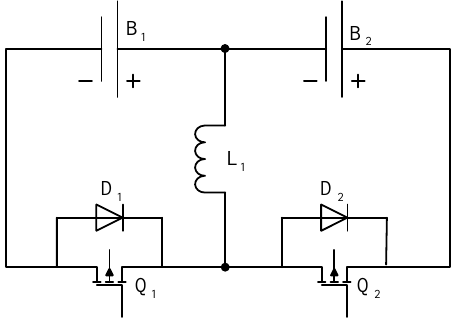
Figure 2. Buck–Boost equalization circuit.